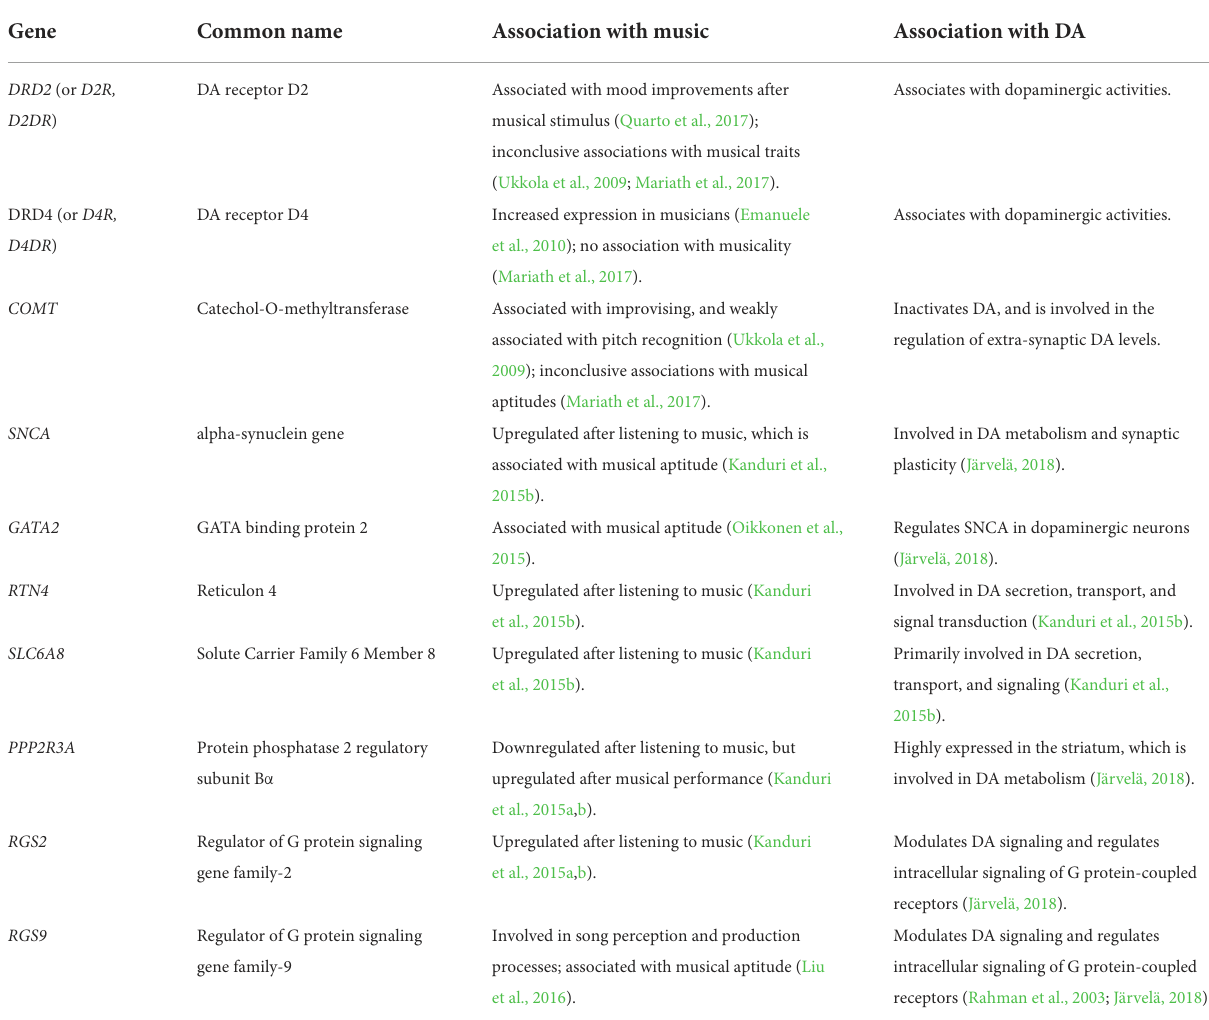
TABLE 1 Dopamine (DA)-related candidate genes associated with listening to